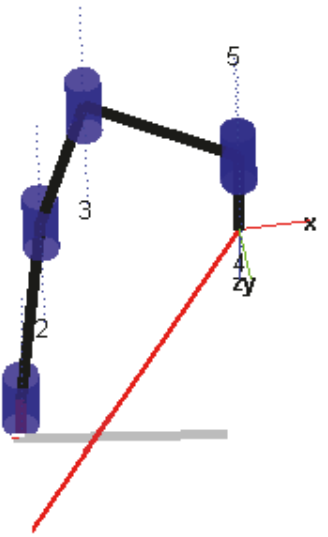
Figure 5: Simulation of motion in a straight line.